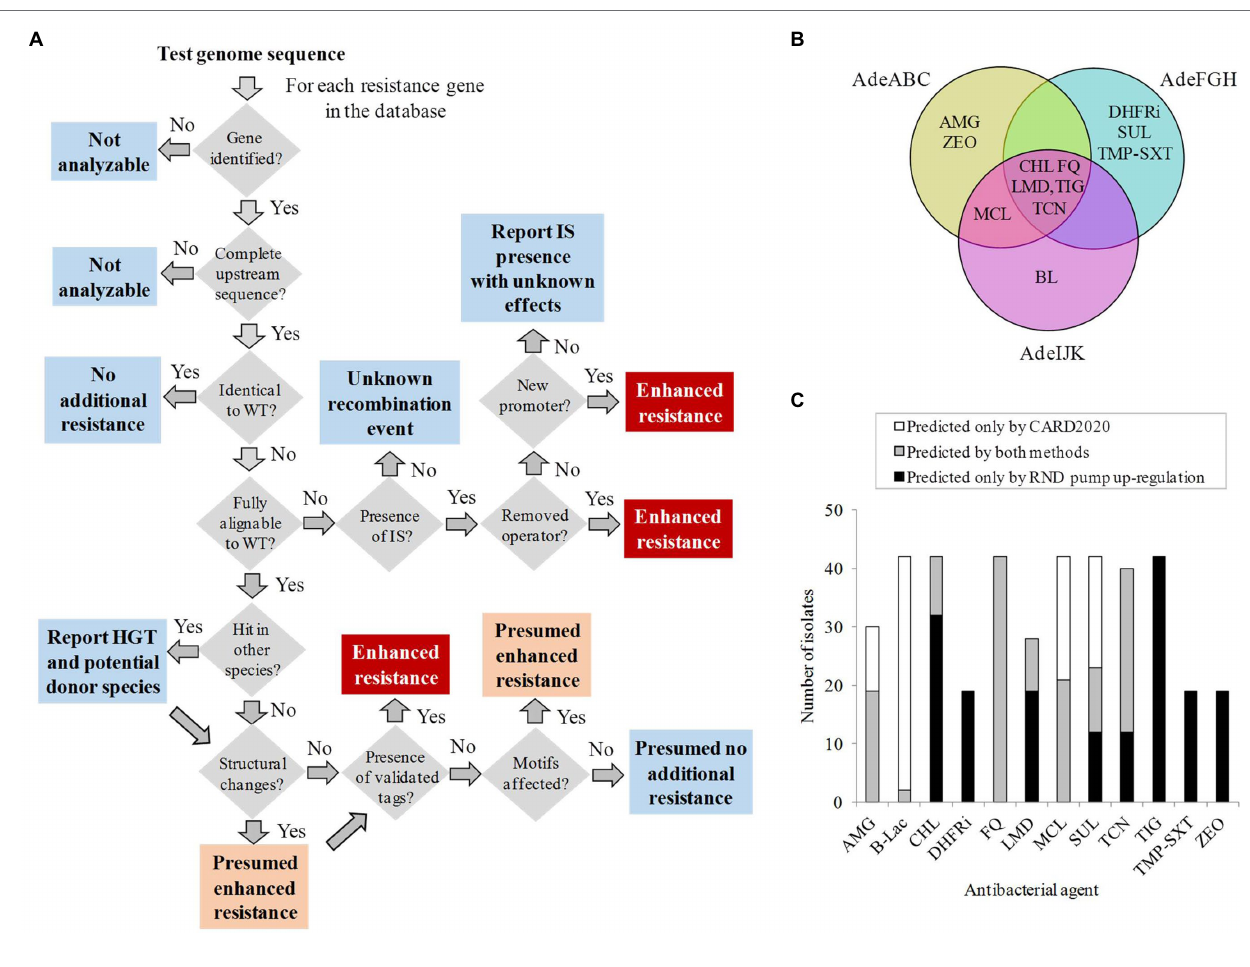
FIGURE 3 | Prediction of the non-coding regulatory resistome. (A) Information management flowchart built with decision (grey), warning (light blue), presumed resistance (orange), and verified resistance (red) boxes. (B) Venn diagram with the antibacterial class descriptors associated with resistance for each RND pump. AMG, aminoglycosides; BL, beta-lactams; CHL, chloramphenicol; DHFRi, dihydrofolate reductase inhibitors; FQ, fluoroquinolones; LMD, lincosamides; MCL, macrolides; SUL, sulfonamides; TCN, tetracyclines; TIG, tigecycline; TMP-SXT, trimethoprim sulfamethoxazole; and ZEO, zeocin. (C) Exclusivity and concordance between CARD2020 and regulatory resistome predictions for 12 antibacterial agents in the 42 isolates at the “Verified” level of our